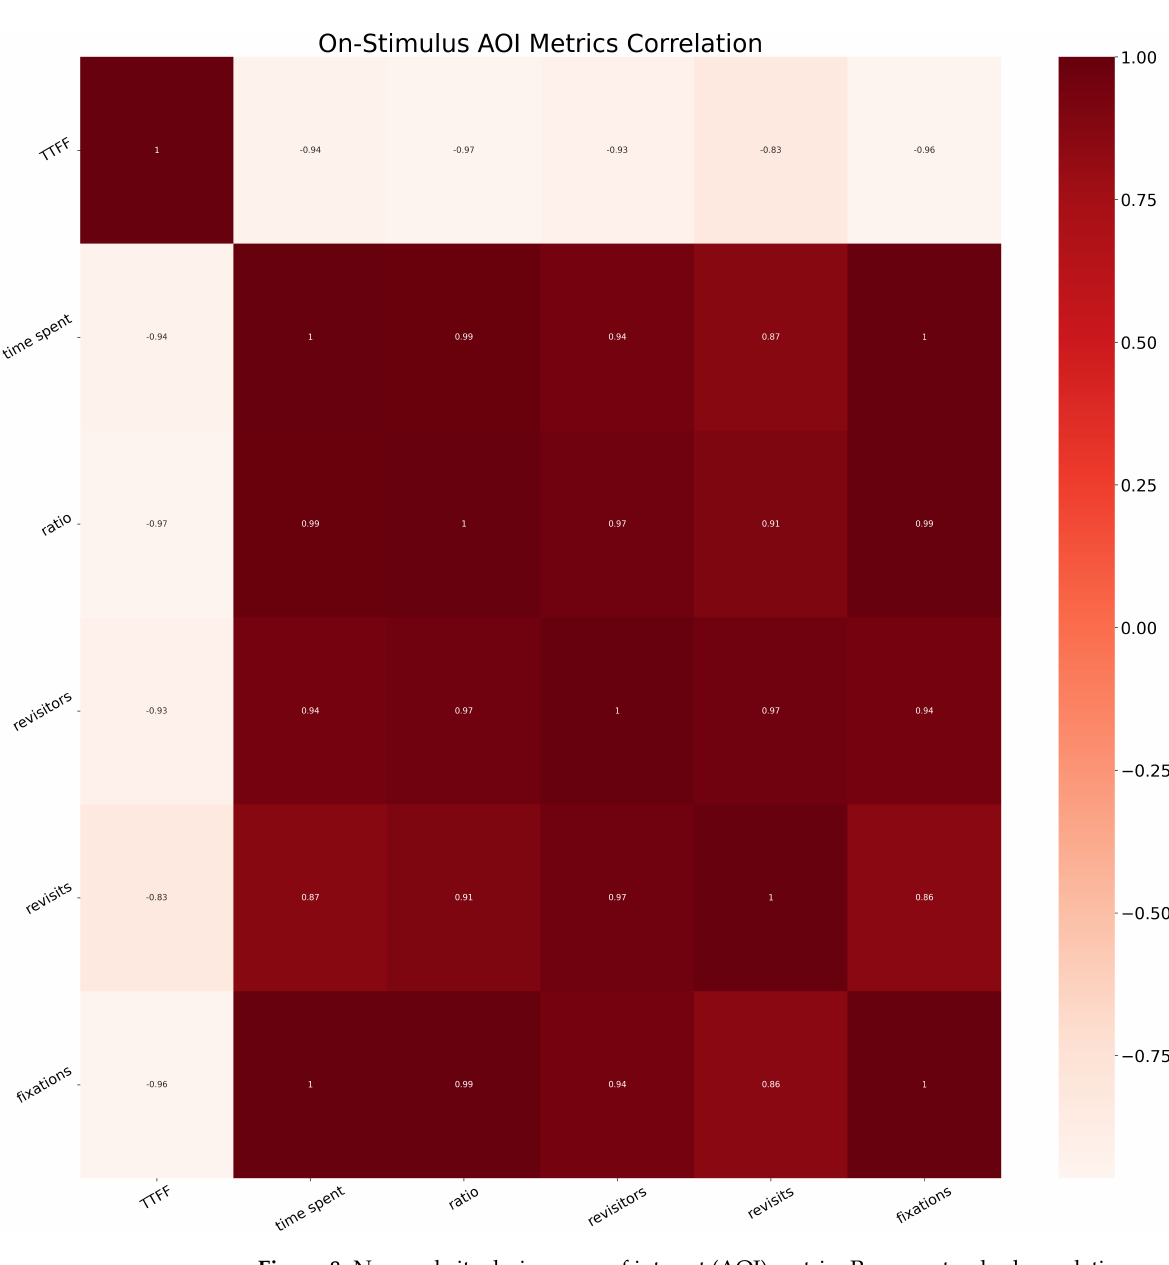
Figure 8. New website design: area of interest (AOI) metrics Pearson standard correlation coefficient. Table 6. New website design: area of interest (AOI) metrics percentage difference against brand